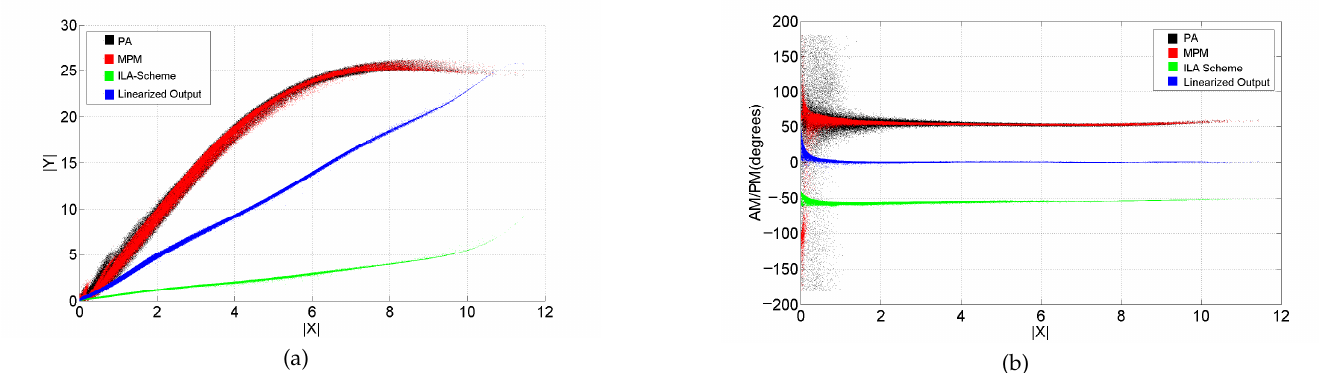
Figure 5. Linearization based on ILA based on MPM for the device ZHL-42W+ at 2000 MHz 32.24 dBm RF-PA. ( a ) AM/AM modeling and linearization stage and ( b ) AM/PM modeling and linearization